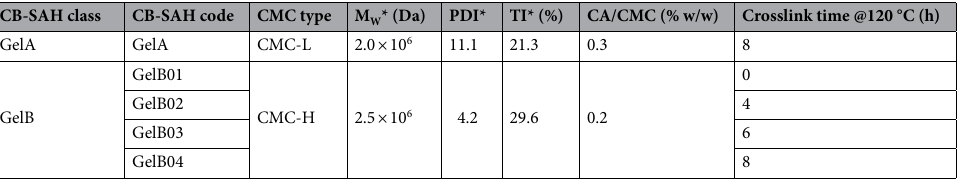
Table 1. Synthesis of CB-SAHs with tunable elasticity. Different CMC types and CA crosslinking parameters were adopted to control the extent of physical and chemical crosslinking in the resulting CB-SAHs. Details on the CMC characterization are provided in the Supplementary Methods. *For each CMC type, values of M w and polydispersity (PDI) were evaluated by size exclusion chromatography, while values of thixotropic index (TI), calculated as described previously 27 , were estimated by means of hysteresis loop tests on 2% w/v aqueous CMC